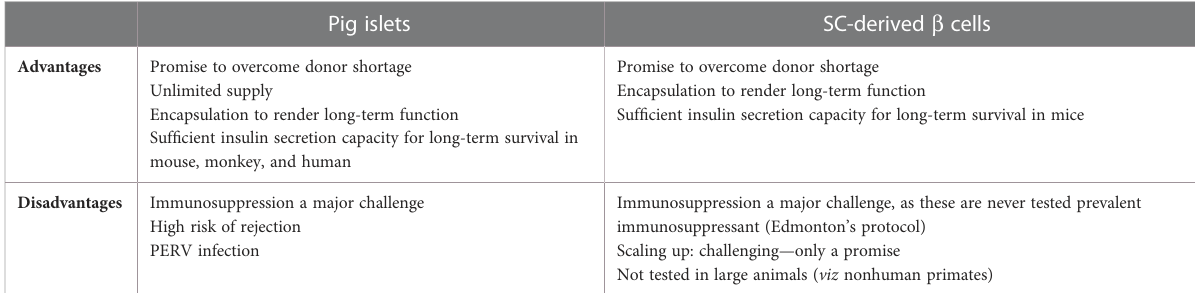
TABLE 5 Comparison between pig islets and stem cell (SC)-derived b cells for the imminent cure of type 1 diabetes. Pig islets SC-derived b